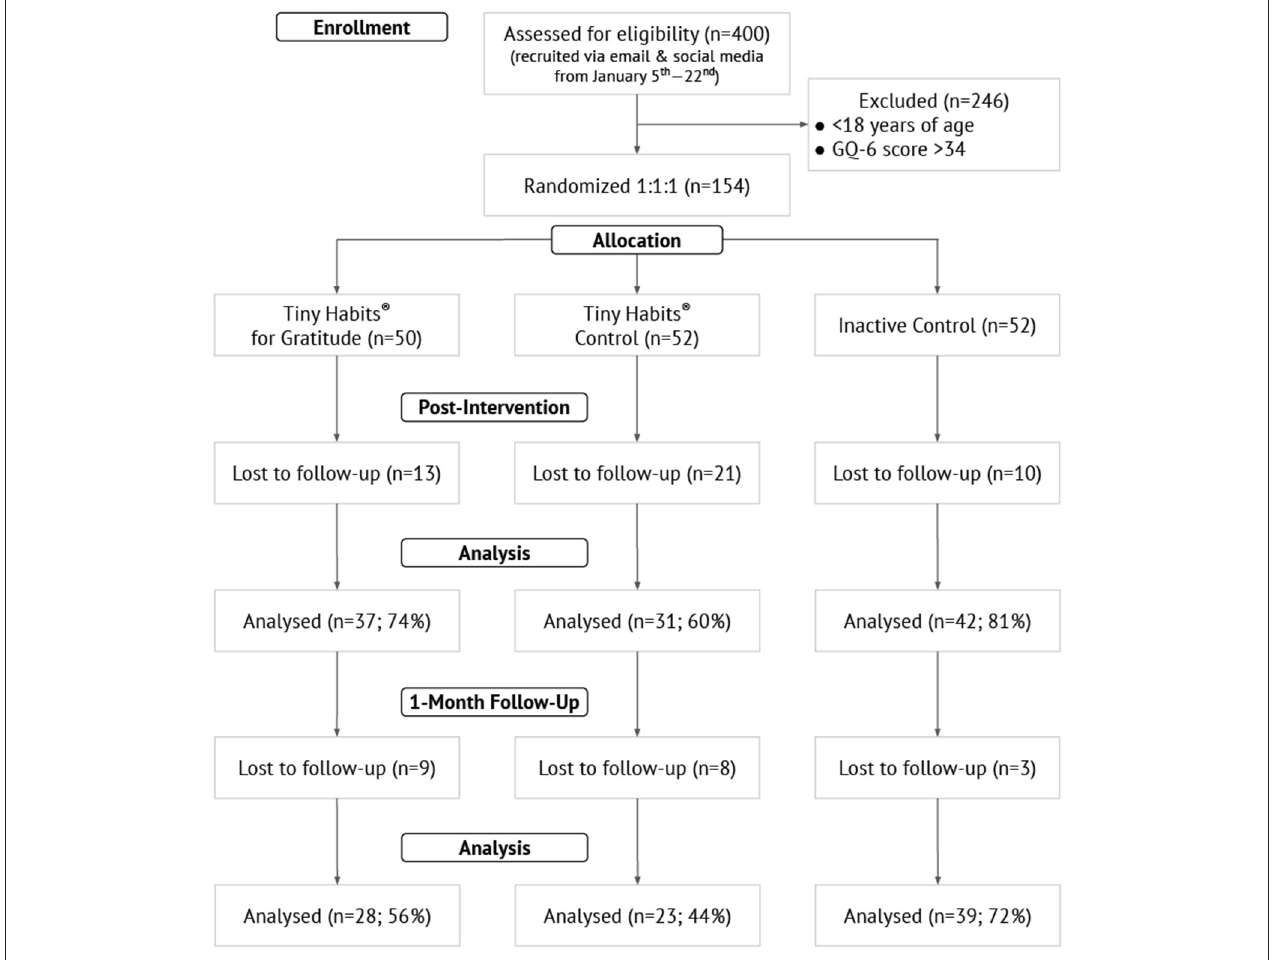
FIGURE 1 | Study flow